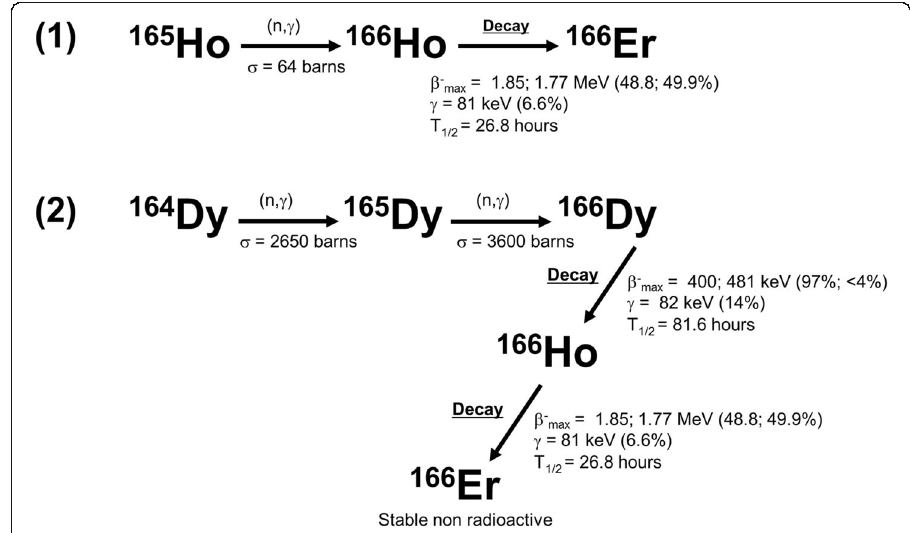
Fig. 1 Diagrams of the production methods of (1) 166 Ho and (2) 166 Dy. Reactor neutron activated 165 Ho